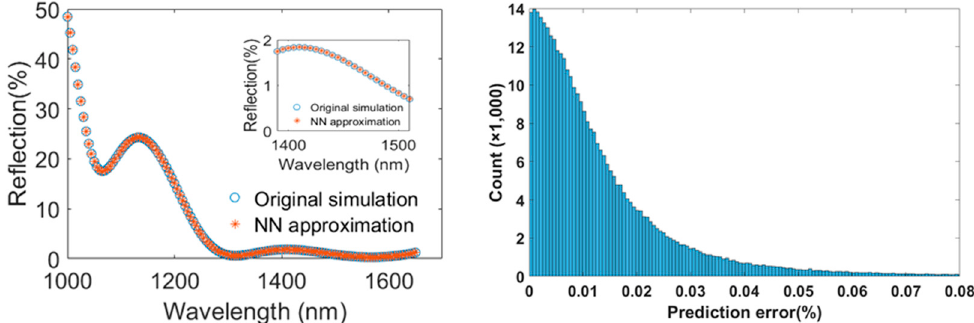
Figure 2. ( a ) The reflection spectrum generated by TMM and NN, and ( b ) the error distribution of the NN prediction against the test dataset.